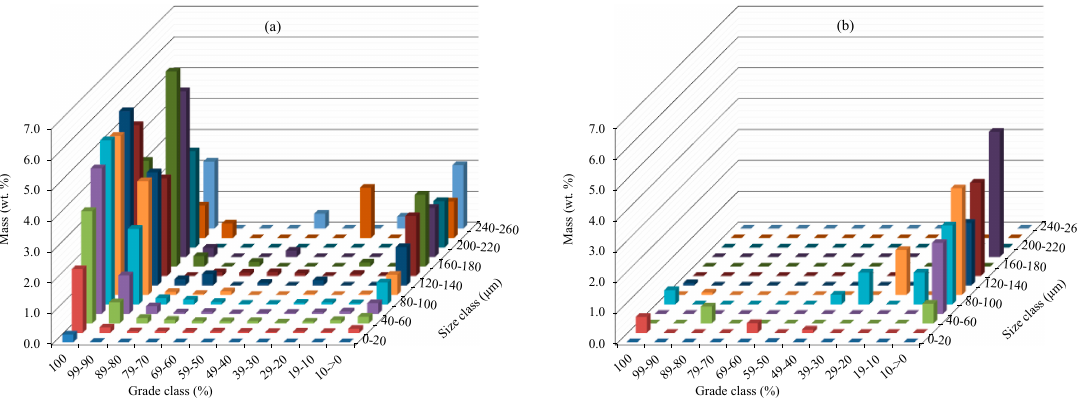
Figure 8. Mineral liberation distribution as a function of particle size with the differential mass and particle grade after comminution and gravity separation. ( a ) Concentrate and ( b ) tailings resulting from this separation.